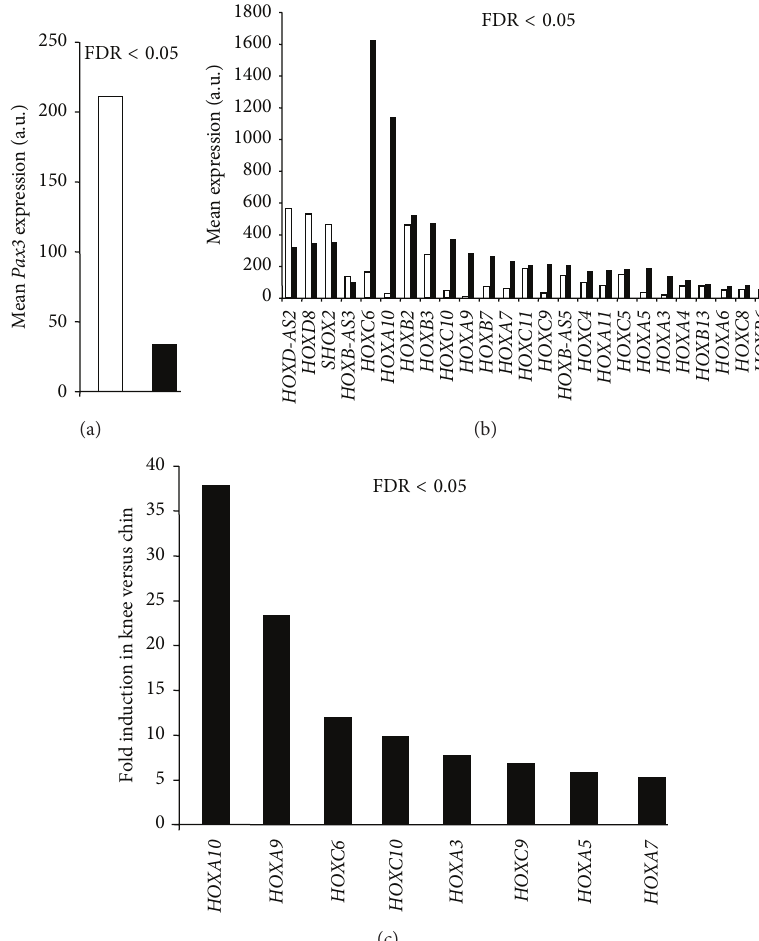
Figure 1: Pax3 and HOX gene expression in paired chin and knee fat depots from large-scale Affymetrix transcriptomics. (a) Mean expression of Pax3 in chin (open bar) and in knee (black bar) fat depots ( 𝑛 = 11 paired). (b) Mean expression of HOX genes in chin (open bars) and knee (black bars) ( 𝑛 = 11 paired). (c) HOX genes with the highest differential expression are